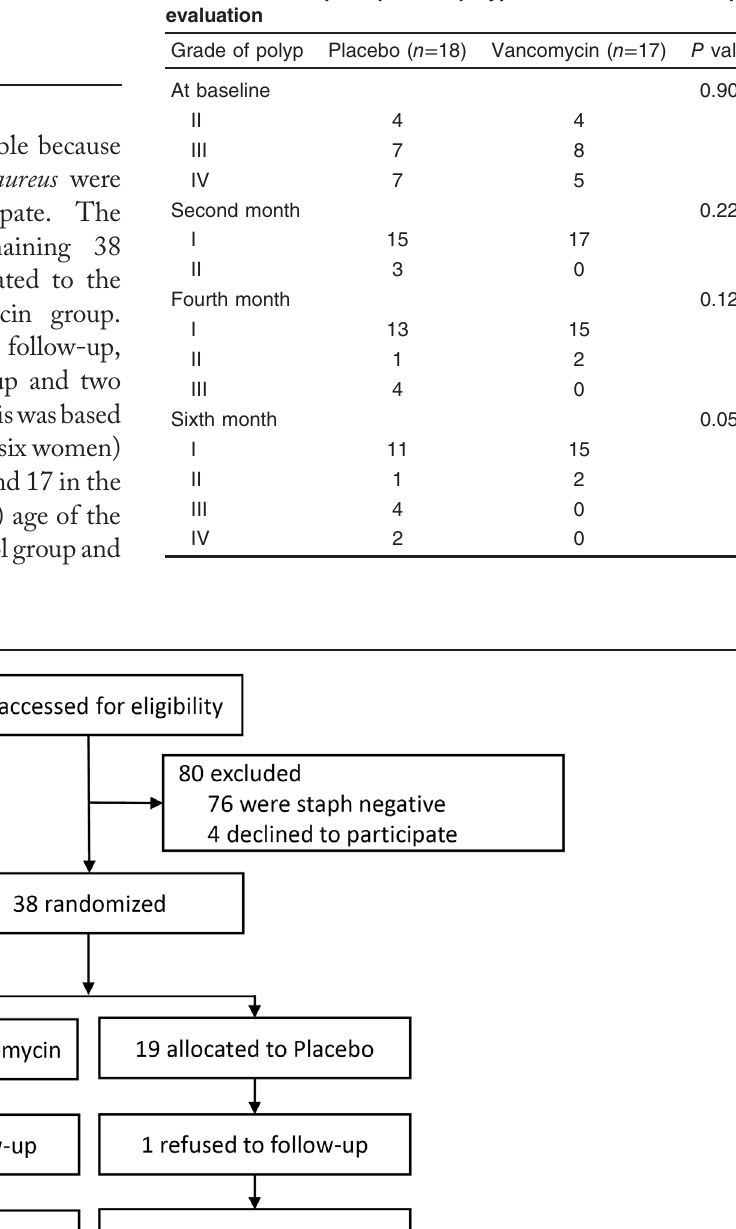
Table 1 The effect of topical vancomycin versus placebo on the size of recurrent postoperative polyposis based on